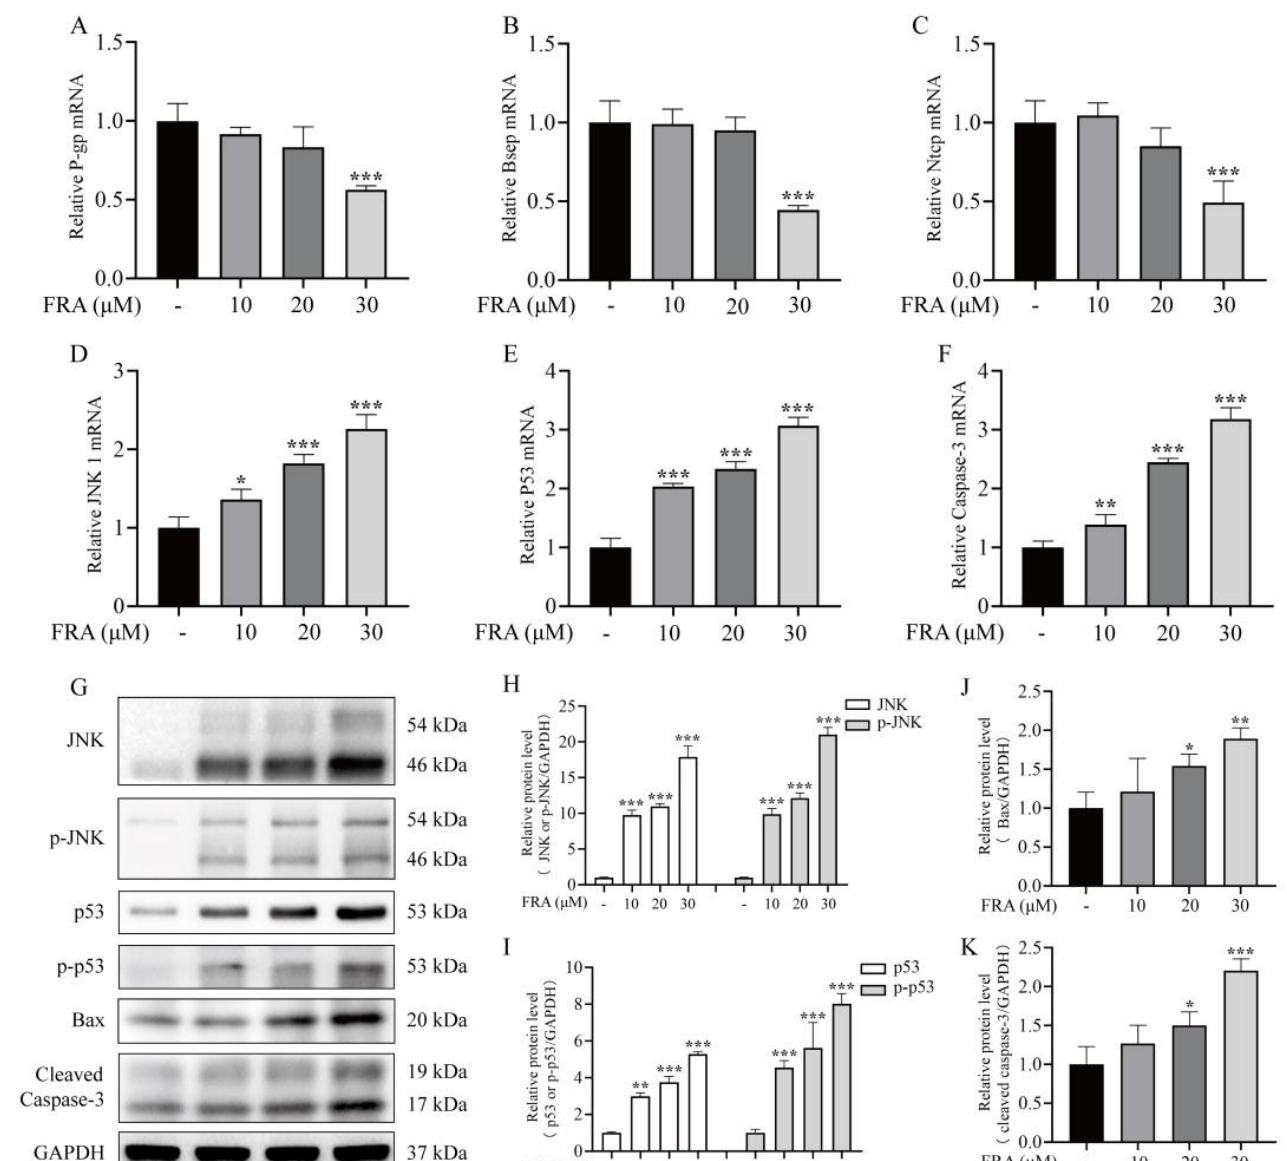
Figure 5. Effects of FRA on the expression levels of bile acid transporters and components of the JNK/p53 pathway. FRA inhibited mRNA expression of the bile acid transporters P-gp ( A ), Bsep ( B ), and NTCP ( C ), and increased those of the apoptotic genes JNK1 ( D ), caspase-3 ( E ), and p53 ( F ). The protein levels of JNK, p-JNK ( H ), p53, p-p53 ( I ), Bax ( J ), and cleaved caspase-3 ( K ) were determined by western blot analysis. GAPDH was used as an internal reference to normalize the results ( G ). Data are presented as the mean ± SD. Each experiment was performed 3 times with 40 randomly selected zebrafish larvae. * p < 0.05 vs. control; ** p < 0.01 vs. control; *** p < 0.001 vs. control.